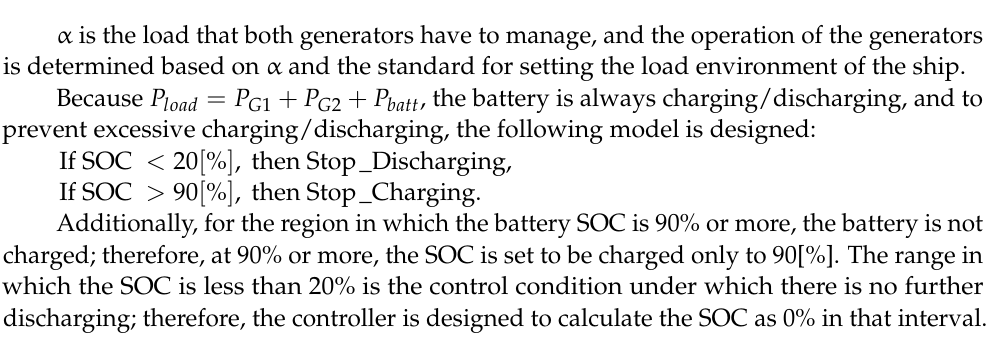
Figure 8. Block diagram of operation sequence for proposed hybrid system.